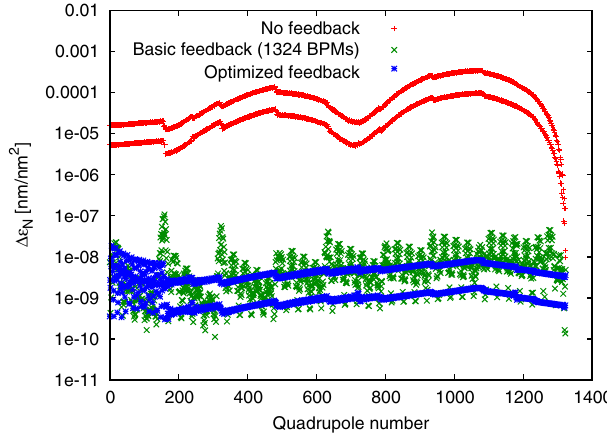
FIG. 21. (Color) Emittance growth caused by a displacement of a quadrupole. Without feedback, even small displacements could have severe consequences, in particular, for certain extra sensitive quadrupoles. By using a basic or optimized feedback system, the tolerance to such displacements is significantly TABLE IV. Emittance growth caused by a displacement of the injected beam. The effect is severe if no feedback is used but is strongly improved by the use of feedback. The optimized feed- back system is particularly efficient. = (cid:1) d 2 [ nm =(cid:3) m 2 ] Feedback setup (cid:1) (cid:2) N No feedback 5.13 Basic feedback (1324 BPMs)